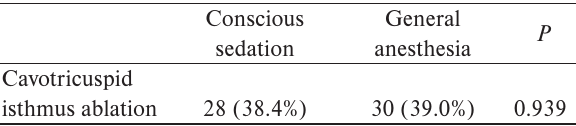
Table 2. Cavotricuspid isthmus ablation.